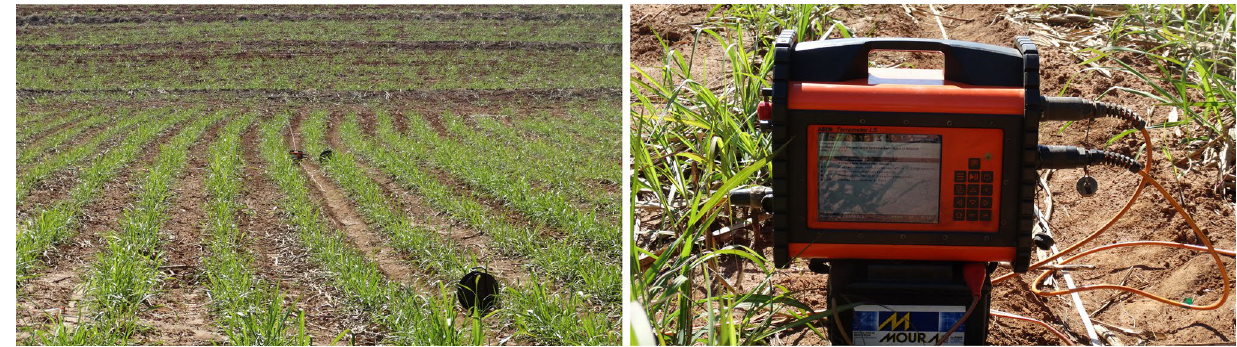
Fig. 6 Geophysical data acquisition, with panoramic view of the from the end of the electric tomography line (left) and detail of the equip- ment in operation